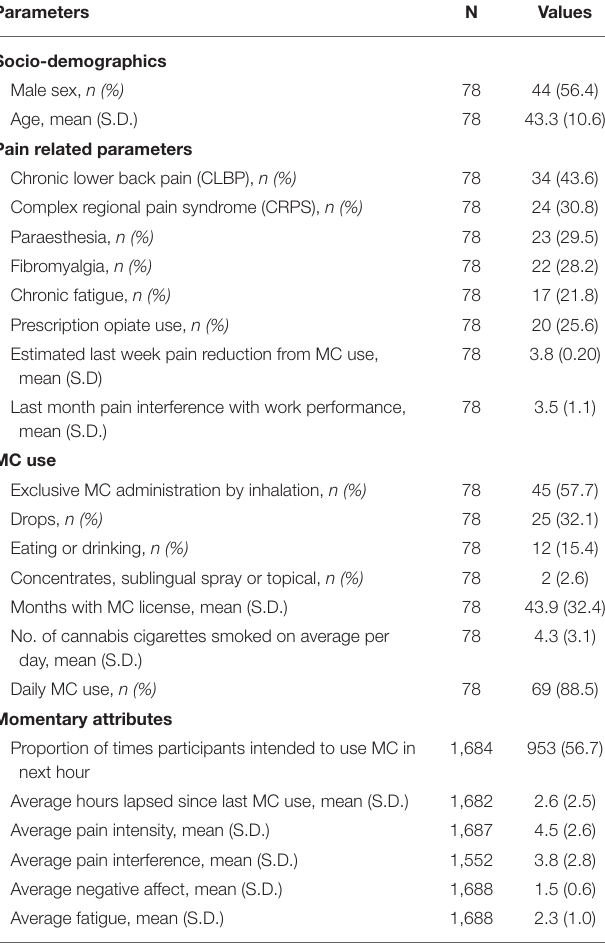
TABLE 1 | Sample characteristics. TABLE 2 | Results from mixed effects models predicting intention to use cannabis